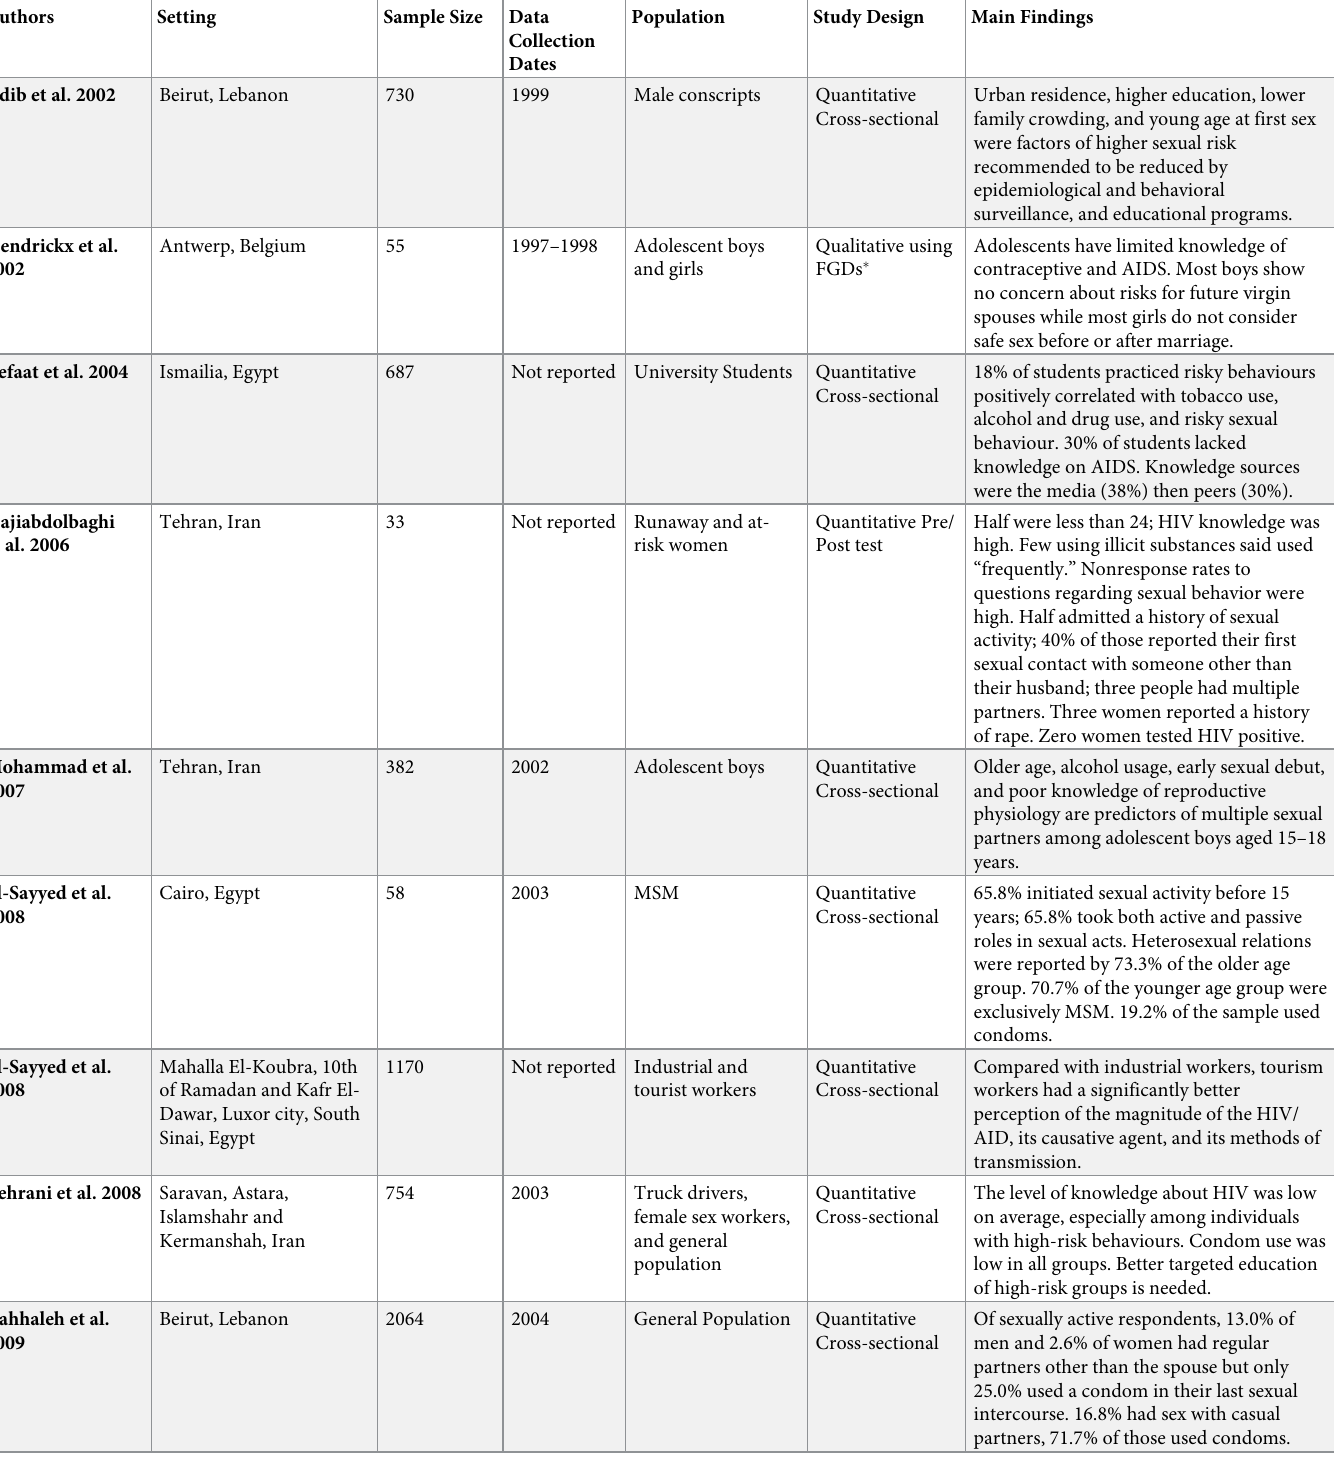
Table 1. Characteristics of research studies included in the scoping